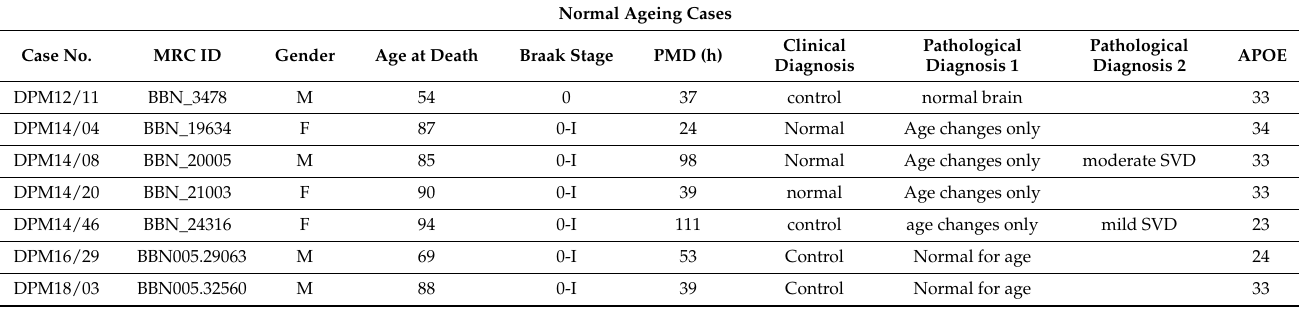
Table 1. Cases used in the